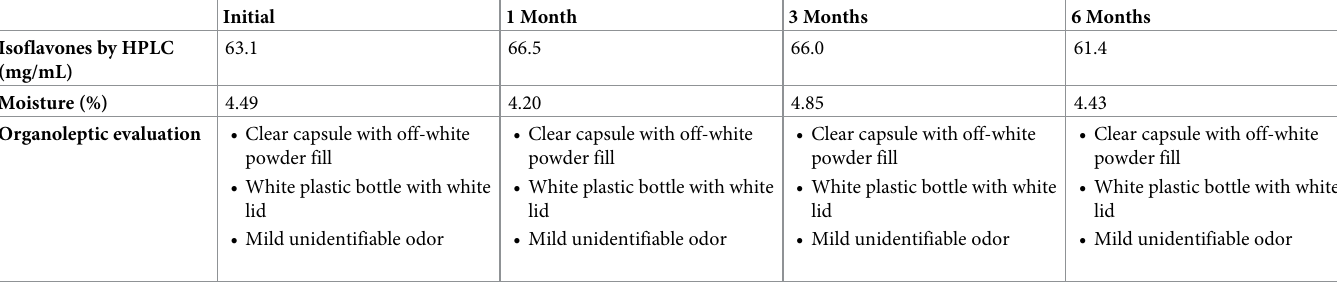
Table 8. Brief summary of the results of the accelerated stability testing (40˚C/ 60% RH).